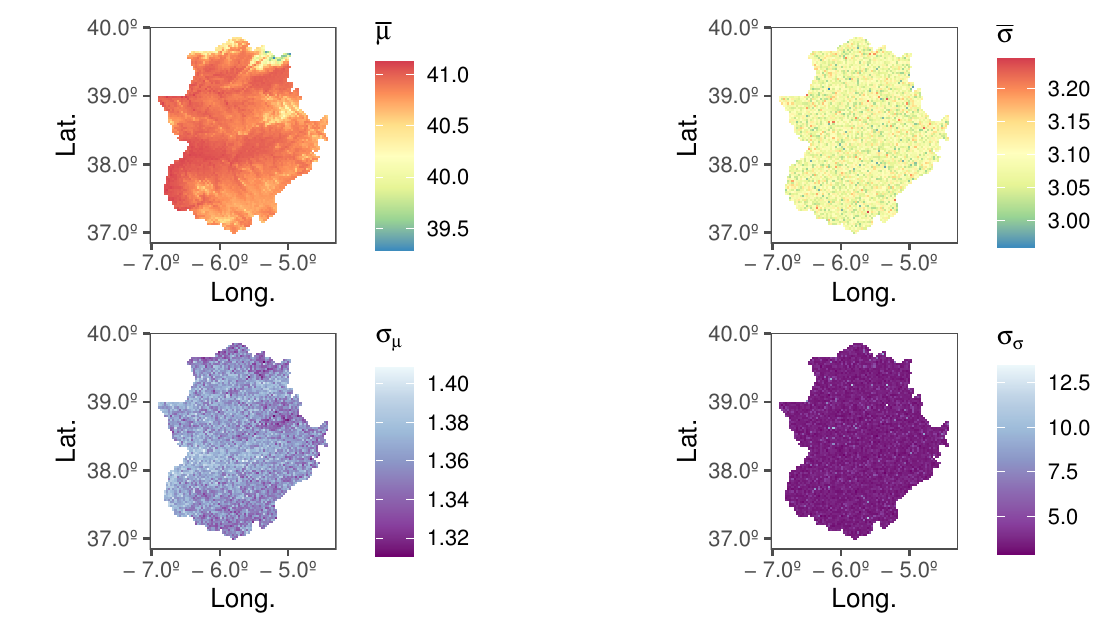
Figure 7. Spatial posterior distributions of the mean ( left ) and the standard deviation ( right ) of the location ( top row) and scale ( bottom row) parameters.